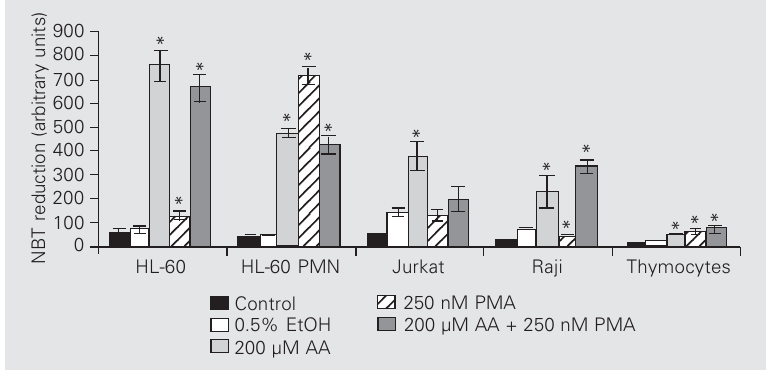
Figure 1. Nitroblue tetrazolium (NBT) reduction following cell exposure to arachidonic acid (AA) or phorbol 12-myristate 13-acid (PMA). Cells (1 x 10 7 /ml, 150 µl; 6 samples each) were treated for 1 h with 0.05% NBT in PBSG (0.13 mM NaCl, 2.7 mM KCl, 0.6 mM CaCl 2 , 1.0 mM MgCl 2 , 5 mM glucose and 10 mM NaH 2 PO 4 /Na 2 HPO 4 , pH 7.4) and 0.5% ethanol (EtOH), 200 µM AA, 250 nM PMA or a combination of the last two agents, at 37 º C. A sample (control) was treated with acetic acid (0.5 volumes) prior to incubation. NBT reduction in the remaining samples was stopped with 0.5 volumes acetic acid after incubation. Cells were then pelleted and reduced NBT was extracted with 150 µl 50% acetic acid upon sonication. After debris sedimentation, reduced NBT absorption was determined at 560 nm. Results are reported as mean ± SD absorbance. Cell lines tested were: HL-60 (human promyelo- cytic leukemia), both in the undifferentiated form or after differentiation into polymorpho- nuclear- (PMN) like cells upon treatment with 100 nM all-trans retinoic acid for 5 days; Jurkat (human T-cell leukemia) and Raji (human B-cell leukemia). Thymocytes were obtained from male albino rats using 4 x 10 7 cells/ml. *P < 0.05 compared to ethanol-treated cells (Student t